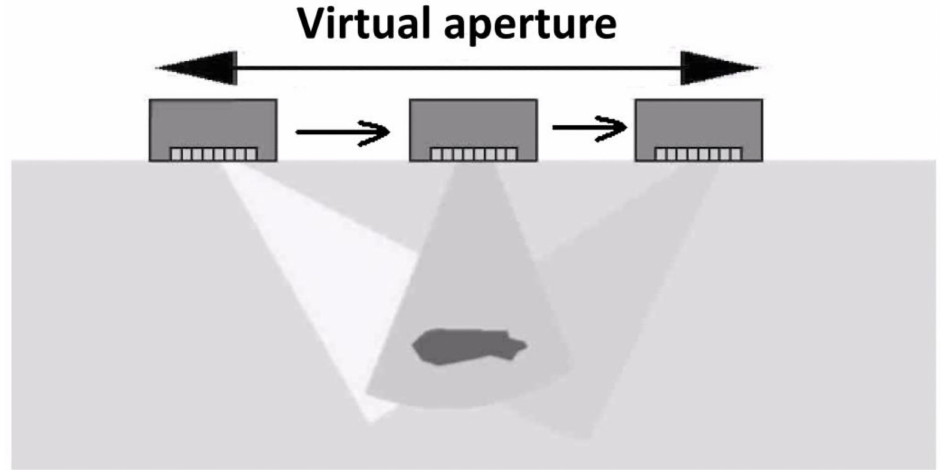
Figure 17. Realization of the SAFT